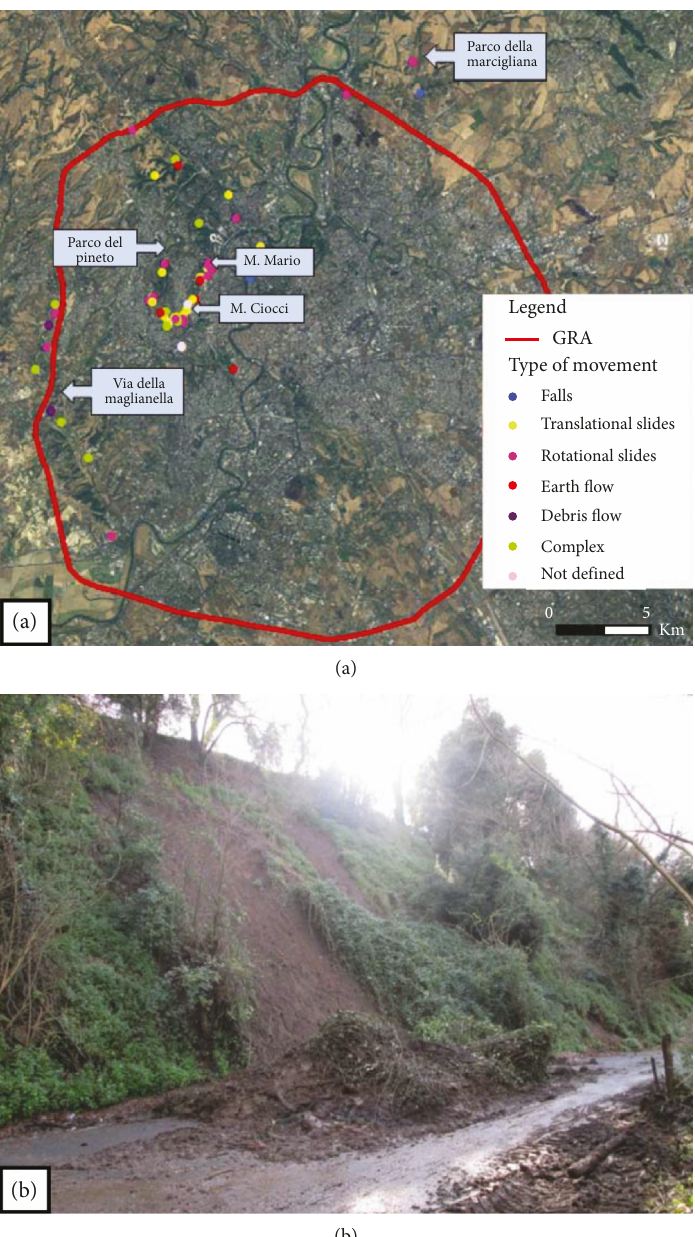
Figure 2: (a) Location of landslides inventoried in the Rome urban area after the exceptional rainfall of January 31-February 2, 2014 (from [38]); (b) an example of landslide triggered on Monte Mario Hill during the 2014